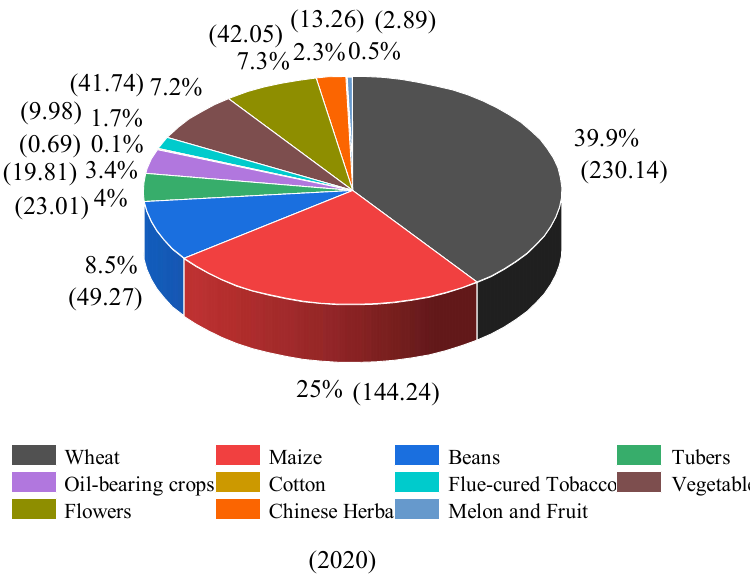
Figure 5. Planting structure variation of main crops from 2010 to 2020. Data in parentheses are planting areas of corresponding crop, areas unit (10 3 ha).